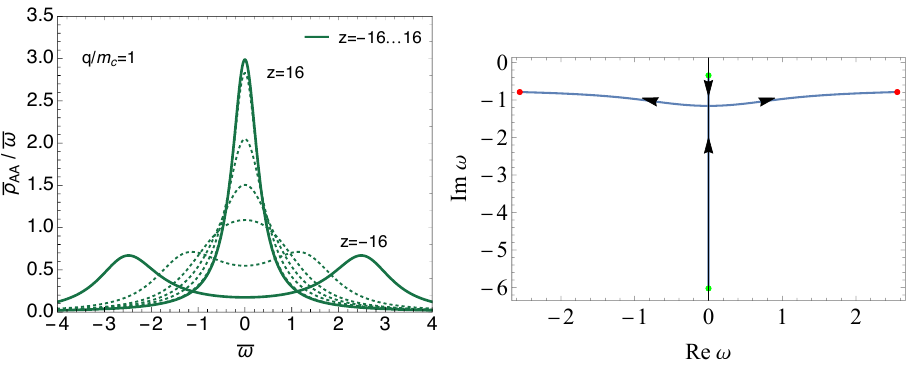
Figure 2. Two di ff erent ways to see the O (4) phase transition via the spectral density. Left: The spectral density over frequency for di ff erent z ∼ T − T c . For the choice of parameters used in this plot, see the discussion in [14]. The di ff usive peak in the unbroken phase z ≫ 0 melts to two peaks in the broken phase, z ≪ 0, representing the propagating pions. Right: the pole structure of the spectral density as a function of temperature. The green points represent z = 16, i.e. the high temperature, unbroken phase, while the arrows indicate the decrease in temperature until the red point z = − 16 . Like in the left plot, the di ff usive poles on the imaginary axis melt down to two propagating